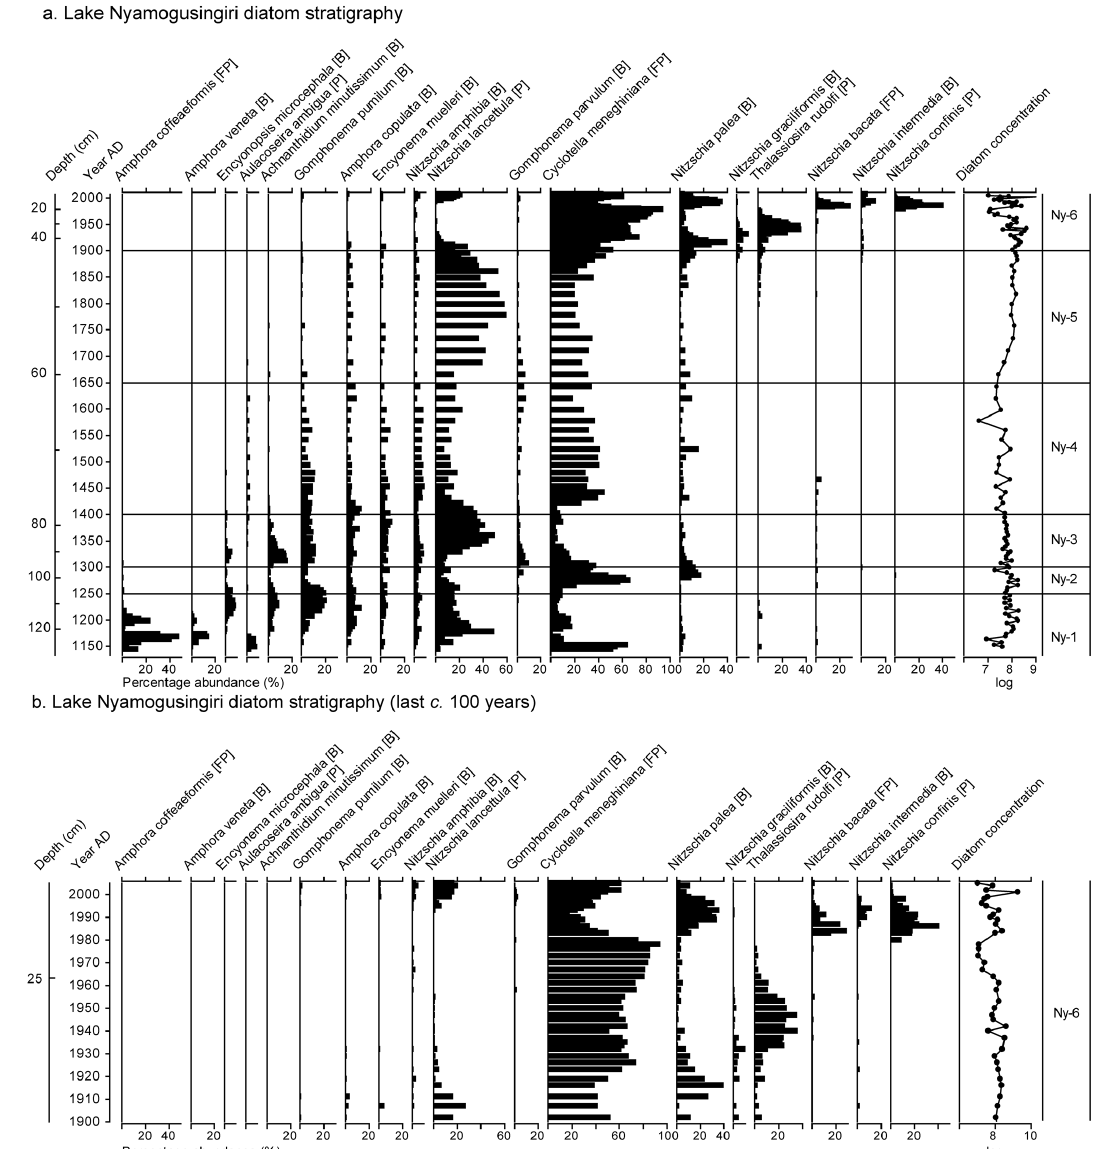
Figure 4. Diatom stratigraphy from (a) Lake Nyamogusingiri (full record), (b) detail of the last 100 years from Lake Nyamogusingiri and (c) Lake Kyasanduka showing selected taxa (>8% in any one sample), ordered by weighted-averaging optimum (ascending) and log diatom concentration (valves per gram of dry sediment). Diatom zones were obtained using the optimal sum of squares method (Birks and Gordon, 1985) in the ZONE program (Juggins, 2002). The letters given in closed brackets after the species name denote the assigned habitat for this study: A is Aerophilous, B is Benthic/periphytic, FP is Facultatively planktonic and P is